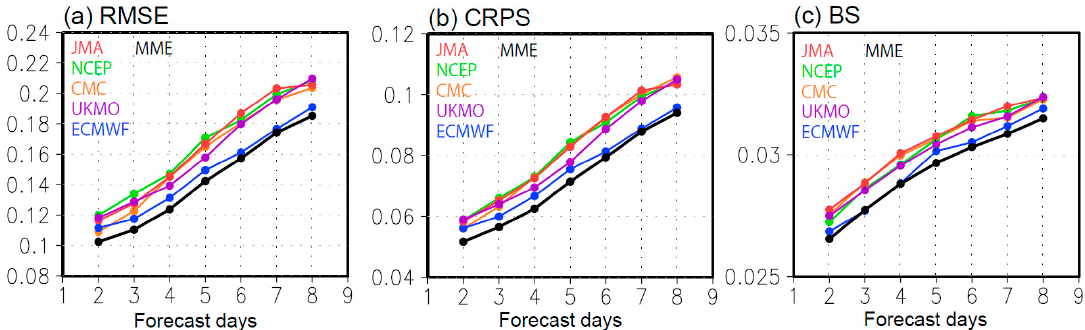
Figure 8. ( a ) Root mean square error (RMSE), ( b ) continuous ranked probability score, and ( c ) Brier score for wind power generation forecasts by CMC (orange), ECMWF (blue), JMA (red), NCEP (green), UKMO (purple), and multi-model ensembles (MME) (black) for the targeted region from April 2011 to May 2013.